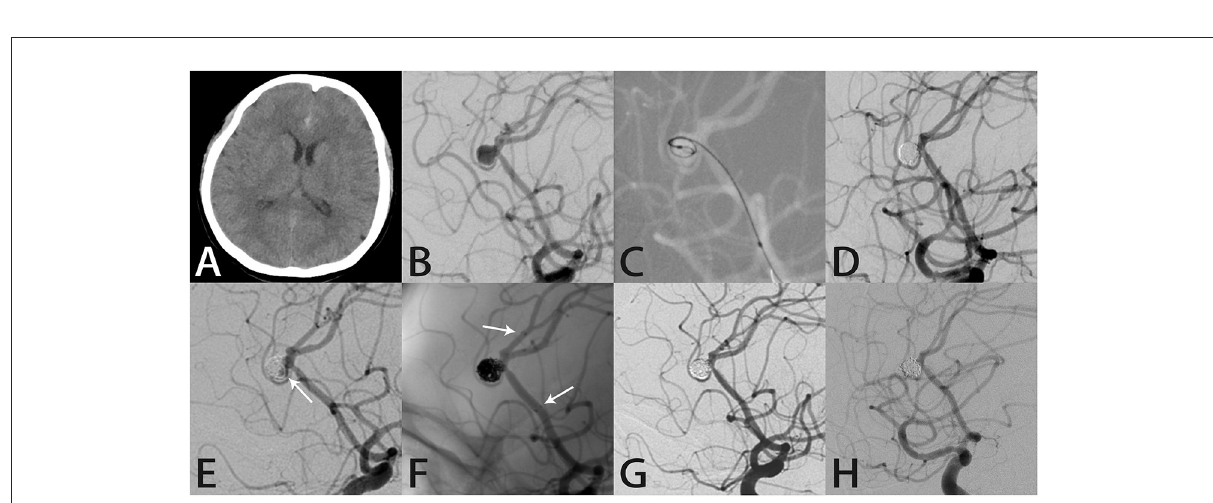
FIGURE3 Images from a 48-year-old woman with a right pericallosal aneurysm (case 4). (A) Computed tomography showed subarachnoid hemorrhage in the longitudinal fissure. (B) Angiography showed a right pericallosal aneurysm. (C) During treatment, an Echelon 10 microcatheter (Medtronic, Dublin, Ireland) was delivered into the aneurysm sac to place the coils. (D) The aneurysm was occluded completely after coil embolization. (E) Follow-up angiography 11 months later showed recurrence in the aneurysm neck (white arrow). (F) Intraprocedural angiography showed the deployed Atlas stent (3.0 × 21mm) covering the aneurysmal neck and coils densely packed within the sac (white arrows indicate the ends of the stent). (G) Angiography immediately after the procedure showed the aneurysm was occluded completely. (H) Follow-up angiography 7 months later showed complete aneurysmal occlusion with the coils densely packed within the aneurysm.